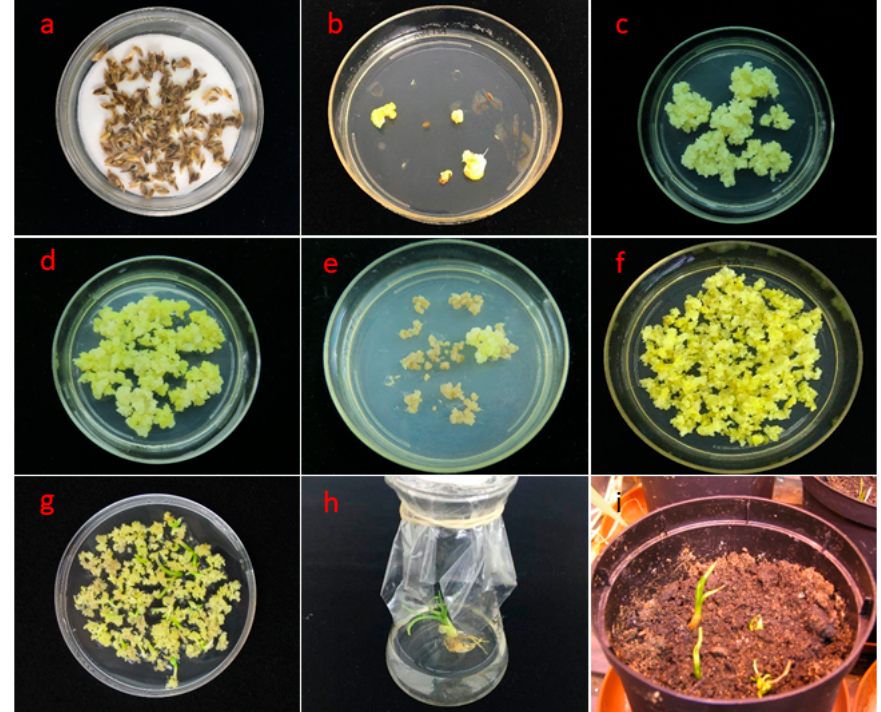
Figure 3. Genetic transformation of Veratrum dahuricum mediated with Agrobacterium tumefaciens carrying pCAMBIA3300-35S-bar expression vector. ( a ) Surface sterilized seeds of Veratrum dahuricum ; ( b ) embryogenic calli induction on modified MS-medium containing 8 mg / L picloram; ( c , d ) proliferation of embryogenic calli in AA medium containing 4 mg / L picloram; ( e ) transgenic callus selection on AA medium containing 4 mg / L 2,4-D and 16 mg / L PPT; ( f ) growing transgenic calli with bar gene on AA selection medium; ( g ) green plant regeneration on R2M medium containing 3 mg / L 6-BA; ( h ) rooted plantlets on hormone free medium R2M; ( i ) potted plantlets in peat soil.